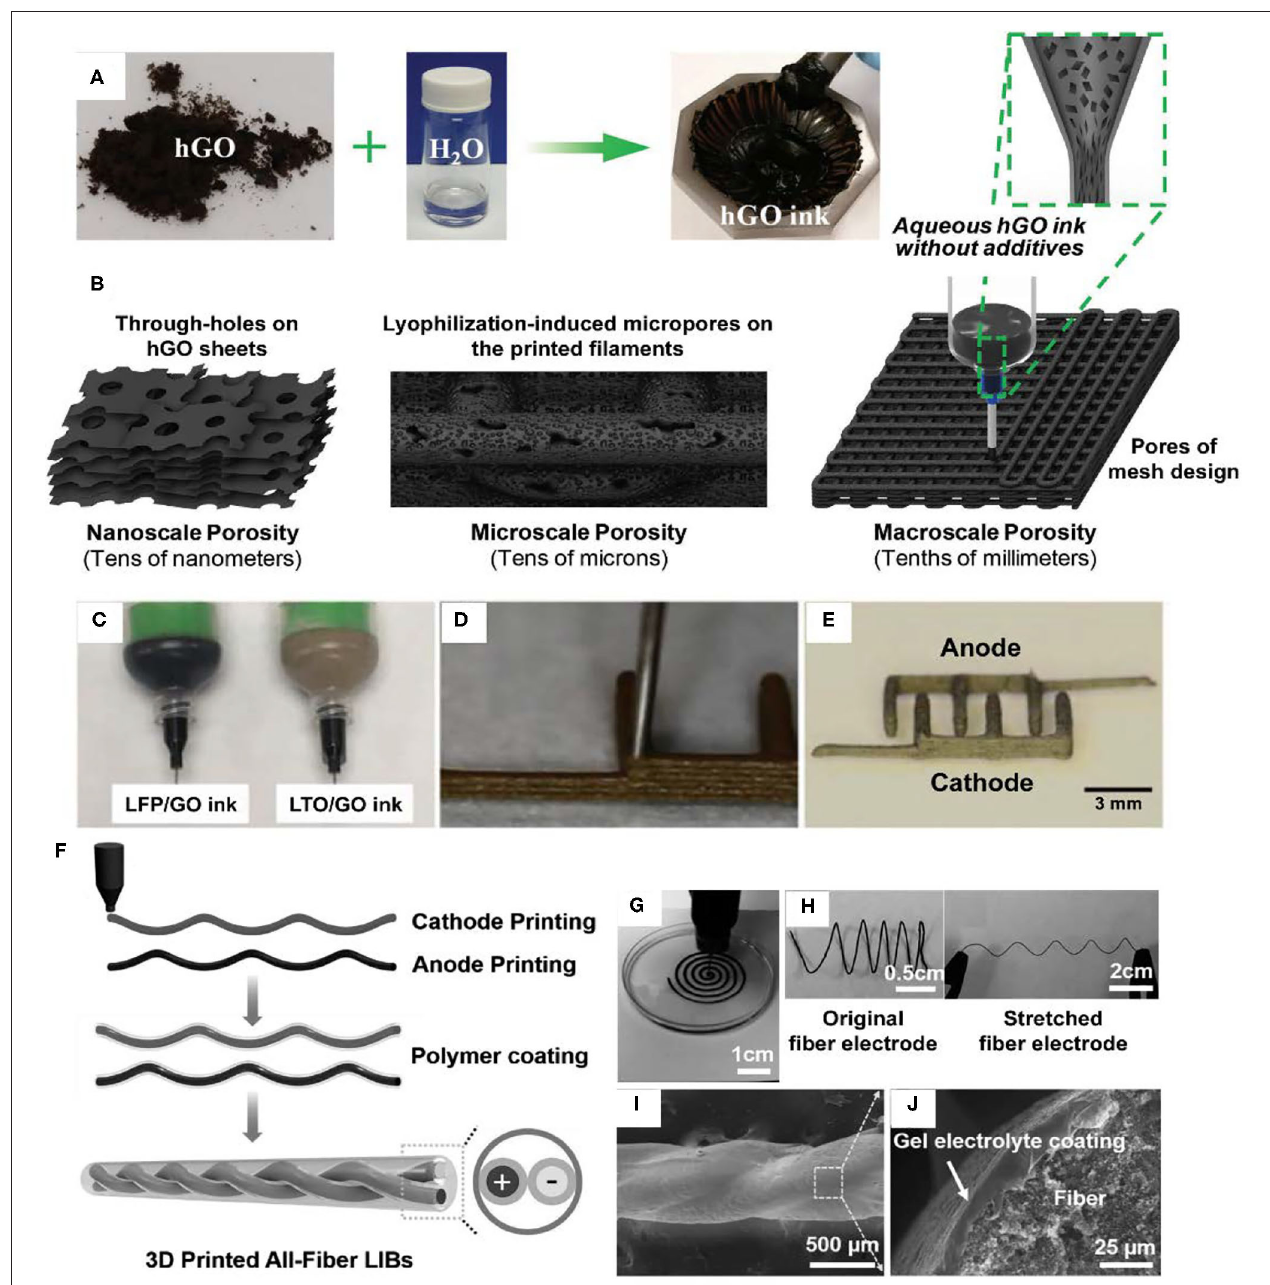
FIGURE 1 | (A) Schematics of making additive-free printable hGO ink. (B) Printing 3D scaffolds electrode with hierarchical porosity. Reproduced from Lacey et al. (2018) with permission from Wiley. (C) Digital images of the LFP/GO and LTO/GO inks. (D) Digital image of layer by layer printing process. (E) Digital image of printed interdigitated electrodes. Reproduced from Fu et al. (2016) with permission from Wiley. (F) Schematic of the design concept and fabrication process of all-fiber flexible Li-ion batteries. (G) Printing the fiber electrode process. (H) Digital images of the dry fiber electrodes. (I) SEM image of yarn fibers with polymer electrolyte coating. (J) Cross-sectional SEM image of the polymer electrolyte coating fibers. Reproduced from Wang et al. (2017) with permission from Wiley. can provide sufficient ion- and electron-transport paths from the bottom to top